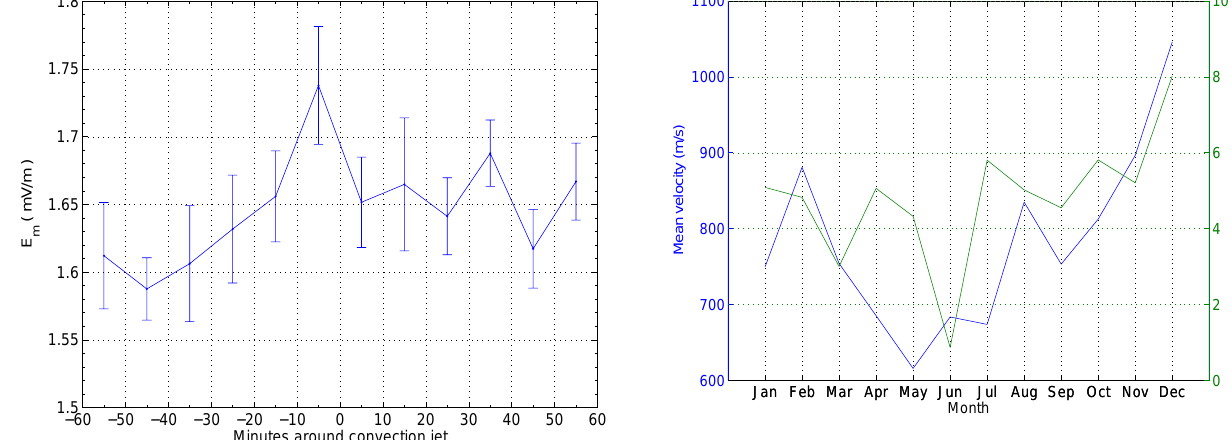
Fig. 5. Superposed epoch analysis of merging electric field, E m , occurring during convection jets. The key time, 0, corresponds to the jet observation time. E m has been propagated from the ACE satellite to the dayside magnetopause. The bars indicate the uncer- tainties of the 10min averages.